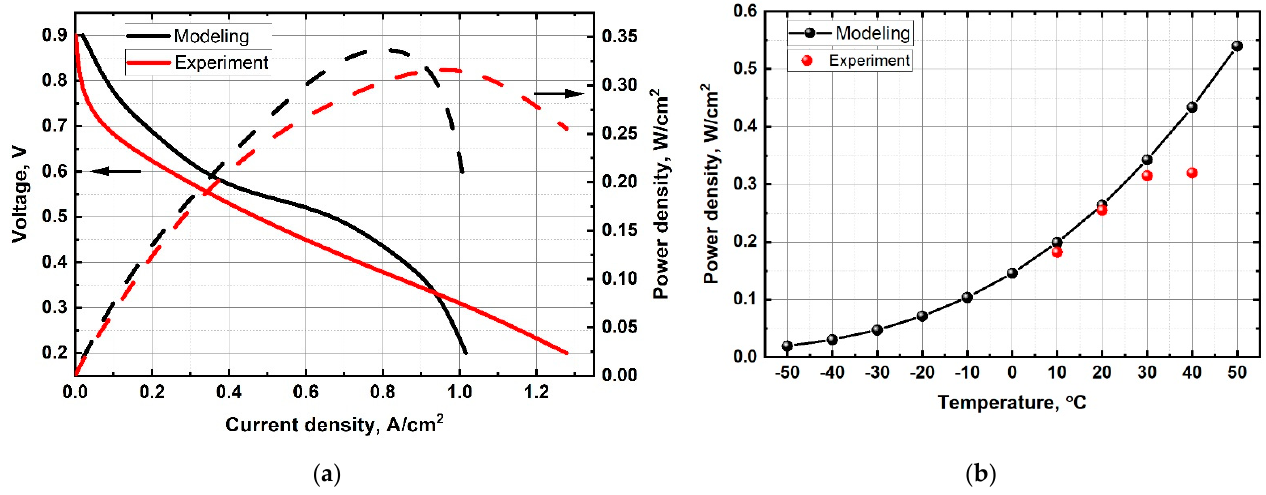
Figure 2. ( a ) Volt-ampere and power characteristics of MEA at an ambient temperature of 30 °C; ( b ) Dependence of power characteristics of MEA on ambient temperature.